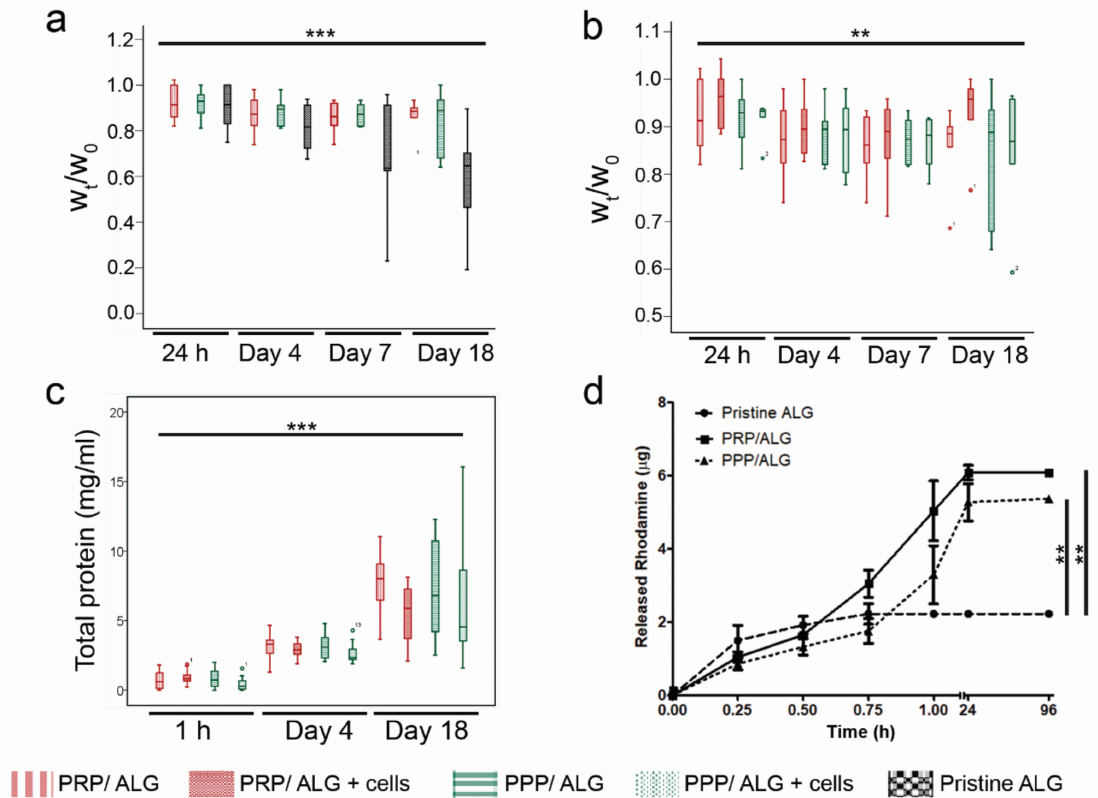
Figure 2. Properties of acellular and cellular dressings. ( a ) Box plots show changes over time of the median and 25th and 75th percentiles of the W t / W 0 ratio of acellular PRP/ALG, PPP/ALG and pristine ALG constructs, where W 0 is the initial postprinting weight, and W t is the construct weight at time t (24 h and days 4, 7, and 18). ( b ) Box plots show the median and 25th and 75th percentiles of the W t / W 0 ratio of cellular and acellular constructs. ( c ) Total protein release from cellular and acellular constructs over time (1 h and days 4 and 18). ( d ) Patterns of RITC-dextran release by different inks. ** p < 0.01; *** p < 0.001. ALG, alginate; PPP, platelet-poor plasma; PRP, platelet-rich plasma; W t , weight at time t ; W 0 , weight at time 0; RITC,